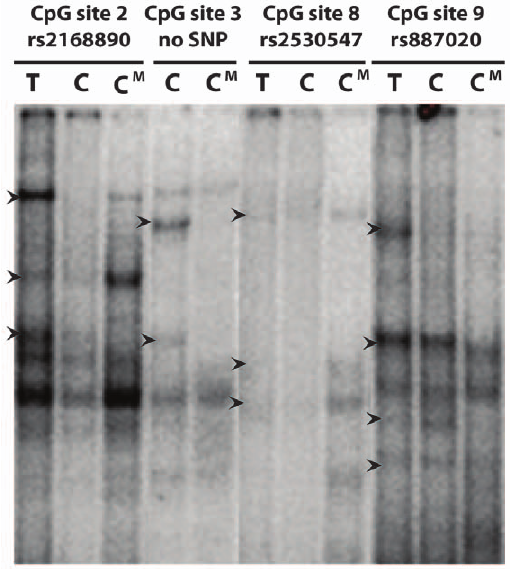
Figure 2. Electric Mobility Shift Assay (EMSA) for four sites in the promoter for Neuropeptide S Receptor 1 gene ( NPSR1 ). The experiment was performed three separate times using nuclear protein extracts from two different cell types (Colo205 and HEK293). Data presented here is a representative gel using nuclear extract from Colo205. Data was similar for nuclear cell extracts from both cell lines. The sites studied included CpG site 2 coinciding with rs2168890 in a predicted HMX2 binding site, CpG site 3 in a predicted STAT1 binding site, CpG site 8 coinciding with rs2530547 in a predicted binding site for MYB, and CpG site 9 coinciding with rs887020 in a predicted binding site for AP1. Arrows indicates sites showing differential binding.